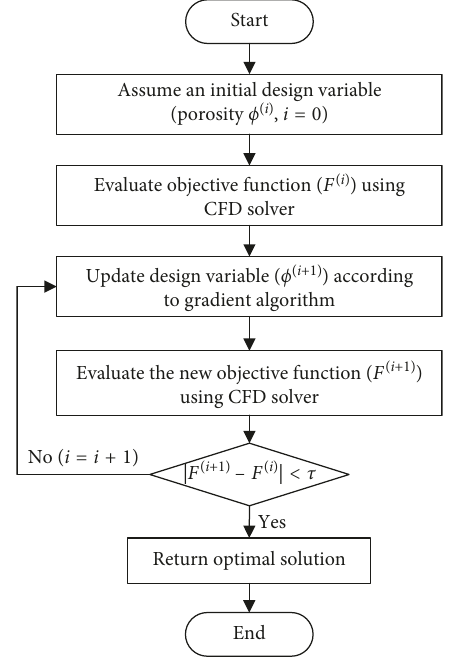
Figure 7: Flow chart of the CFD-based aerodynamic porosity optimization.